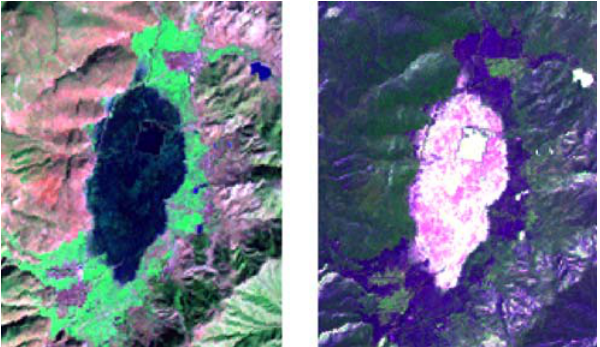
Figure 5 Swamp wetland enhanced results comparison